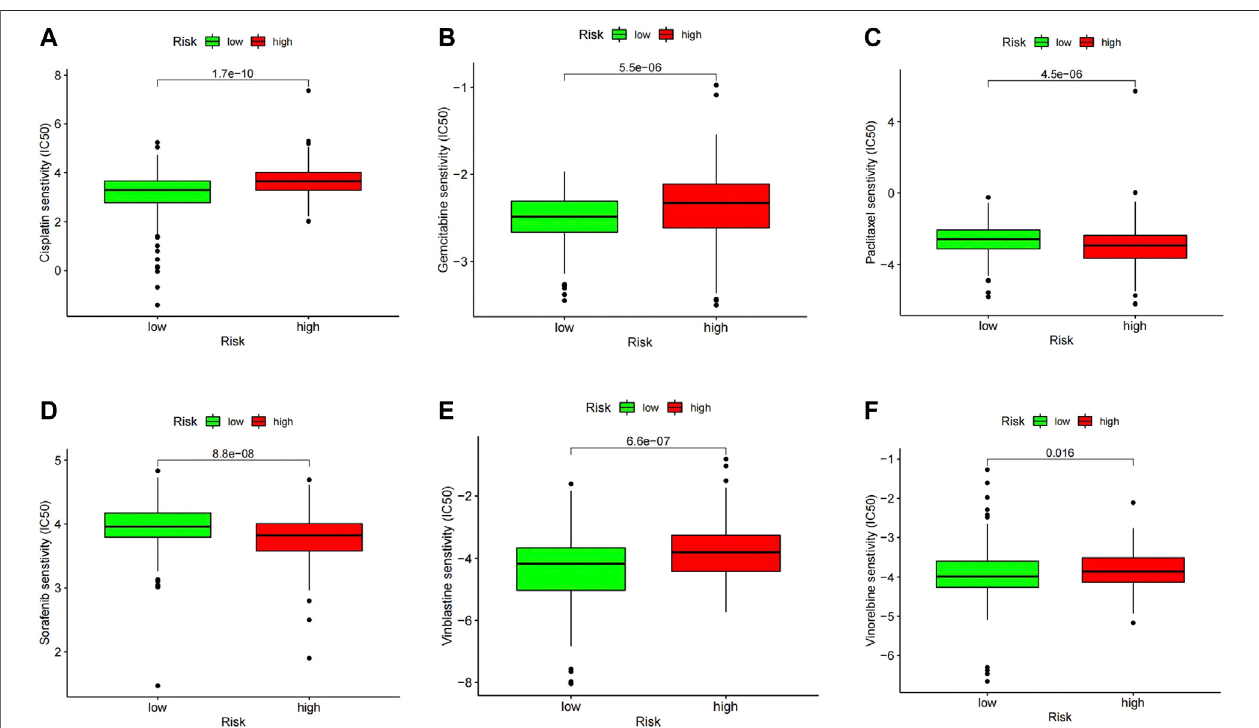
FIGURE9| IC50valuesofseveralcommonlyusedchemotherapeuticdrugsinthehigh-andlow-riskgroupincludingCisplatin (A) ,Gemcitabine (B) ,Vinblastine (C) , and Vinorelbine (D) , Paclitaxel (E) and Sorafenib (F) .